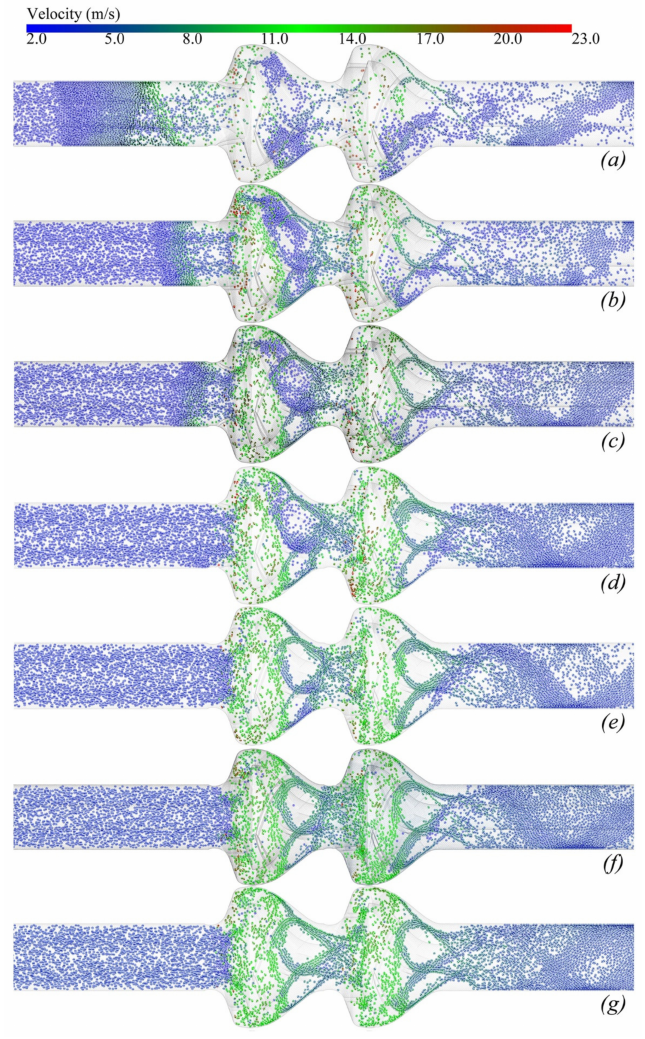
Figure 13. Particle distribution and velocity vector synthesis at different flow rates: ( a ) Q = 200 m 3 /h; ( b ) Q = 300 m 3 /h; ( c ) Q = 360 m 3 /h; ( d ) Q = 420 m 3 /h; ( e ) Q = 480 m 3 /h; ( f ) Q = 540 m 3 /h; ( g ) Q = 600 m 3